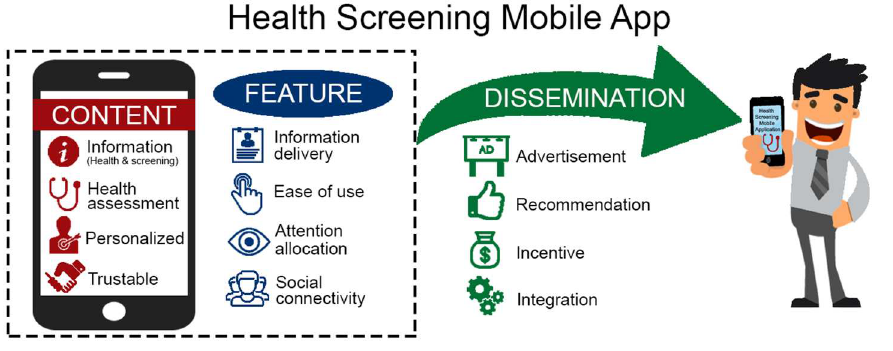
Fig 1. Three main themes of what men want from a health screening mobile